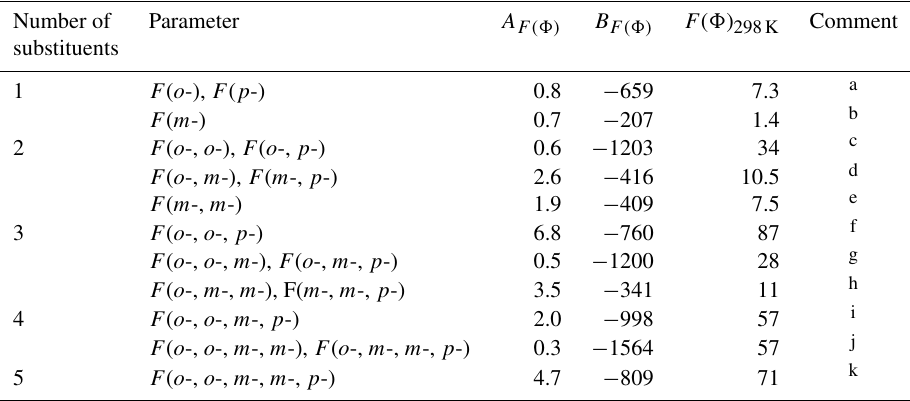
Comments: given parameter contributes to the calculation of k calc for the following methyl-substituted aromatics: a toluene, o -xylene and p -xylene; b toluene and m -xylene; c m -xylene, 1,2,3-trimethylbenzene and 1,2,4-trimethylbenzene; d o -xylene, p -xylene, 1,2,3-trimethylbenzene and 1,2,4-trimethylbenzene; e m -xylene and 1,3,5-trimethylbenzene; f 1,3,5-trimethylbenzene and 1,2,3,5-tetramethylbenzene; g 1,2,3-trimethylbenzene, 1,2,4-trimethylbenzene, 1,2,3,4-tetramethylbenzene,